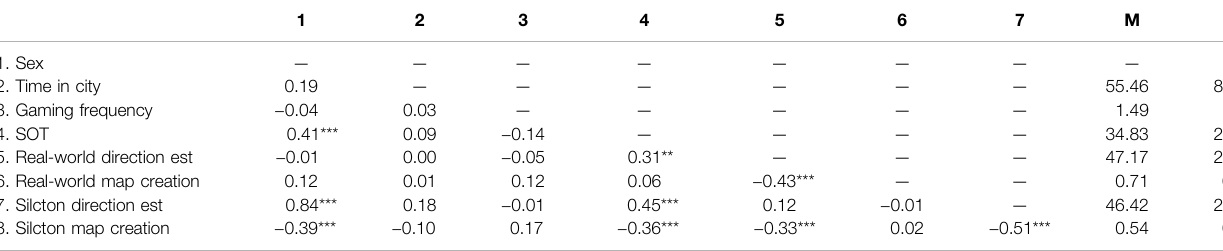
TABLE 1 | Pearson correlations, means, and standard deviations for all variables in Experiment